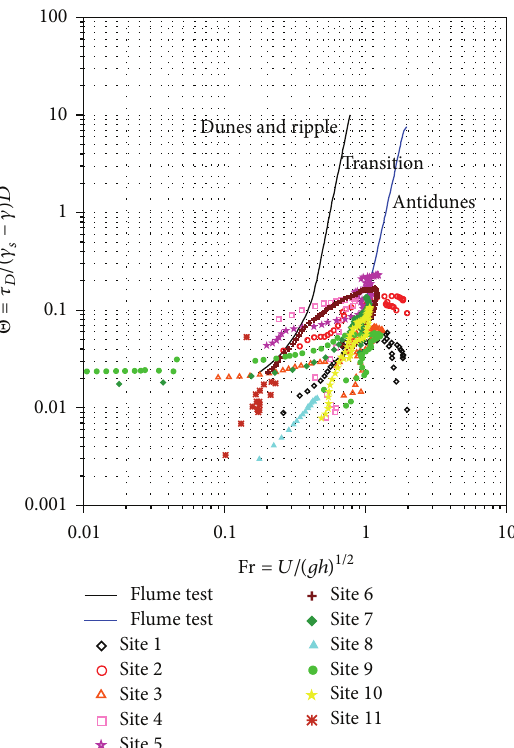
Figure 12: Shields number versus Froude number for Shi-Wen River using 10-year return period. (𝜏 𝑏 /(𝛾 𝑠 − 𝛾)𝐷) , in which 𝜏 𝑏 is bed shear stress, 𝛾 𝑠 and 𝛾 aresedimentandfluiddensities,respectively,and 𝐷 is the grain size to be moved multiplied by acceleration due to gravity. The parameter ( 𝑈/√𝑔ℎ ) represents the Froude number, in which 𝑈 is the flow velocity and 𝑔 and ℎ are the acceleration due to gravity and flow depth, respectively.